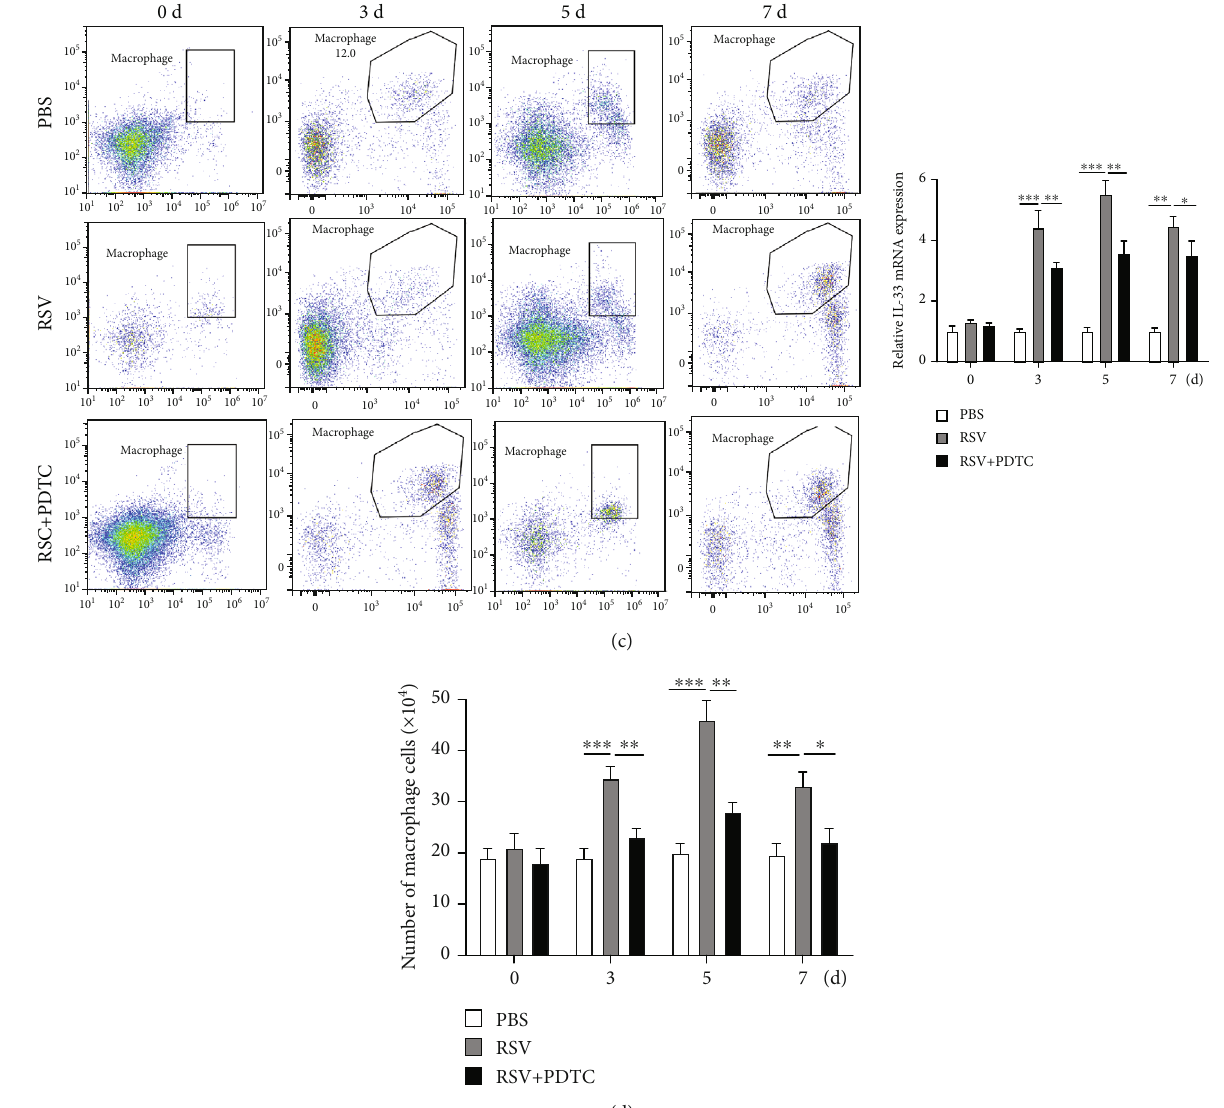
Figure 4: Macrophages are important sources of IL-33 and are regulated by NF- κ B pathway in RSV-induced mice. (a) The number of alveolar macrophages, lymphocyte, and eosinophils in BAL of mice. (b) Flow cytometry analysis was performed to sort alveolar macrophages at di ff erent times after RSV infection. (c) Flow cytometry analysis was performed to sort alveolar macrophages at di ff erent times after RSV +PDTC treatment. (d) The IL-33 expression in alveolar macrophages at di ff erent times after RSV +PDTC treatment was examined by RT-PCR analysis. All data were expressed as the mean ± SD ( n = 3 ). Each value of ∗ p < 0 : 05 , ∗∗ p < 0 : 01 , and ∗∗∗ p < 0 : 001 was considered to be signi fi cant di ff